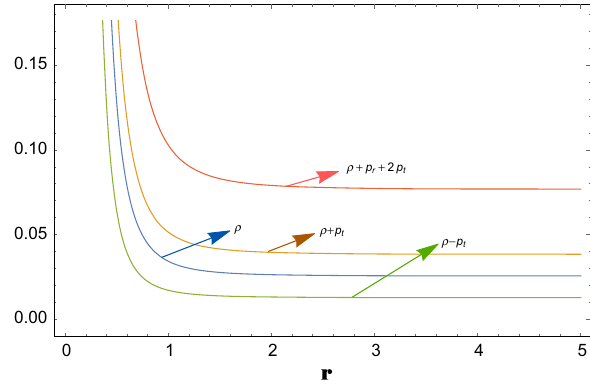
Fig. 2 Behaviour of the matter-energy density, NEC, DEC and SEC, with r 0 = 1 ,γ = 1, m = 0 . 5 and χ = 6, for model A